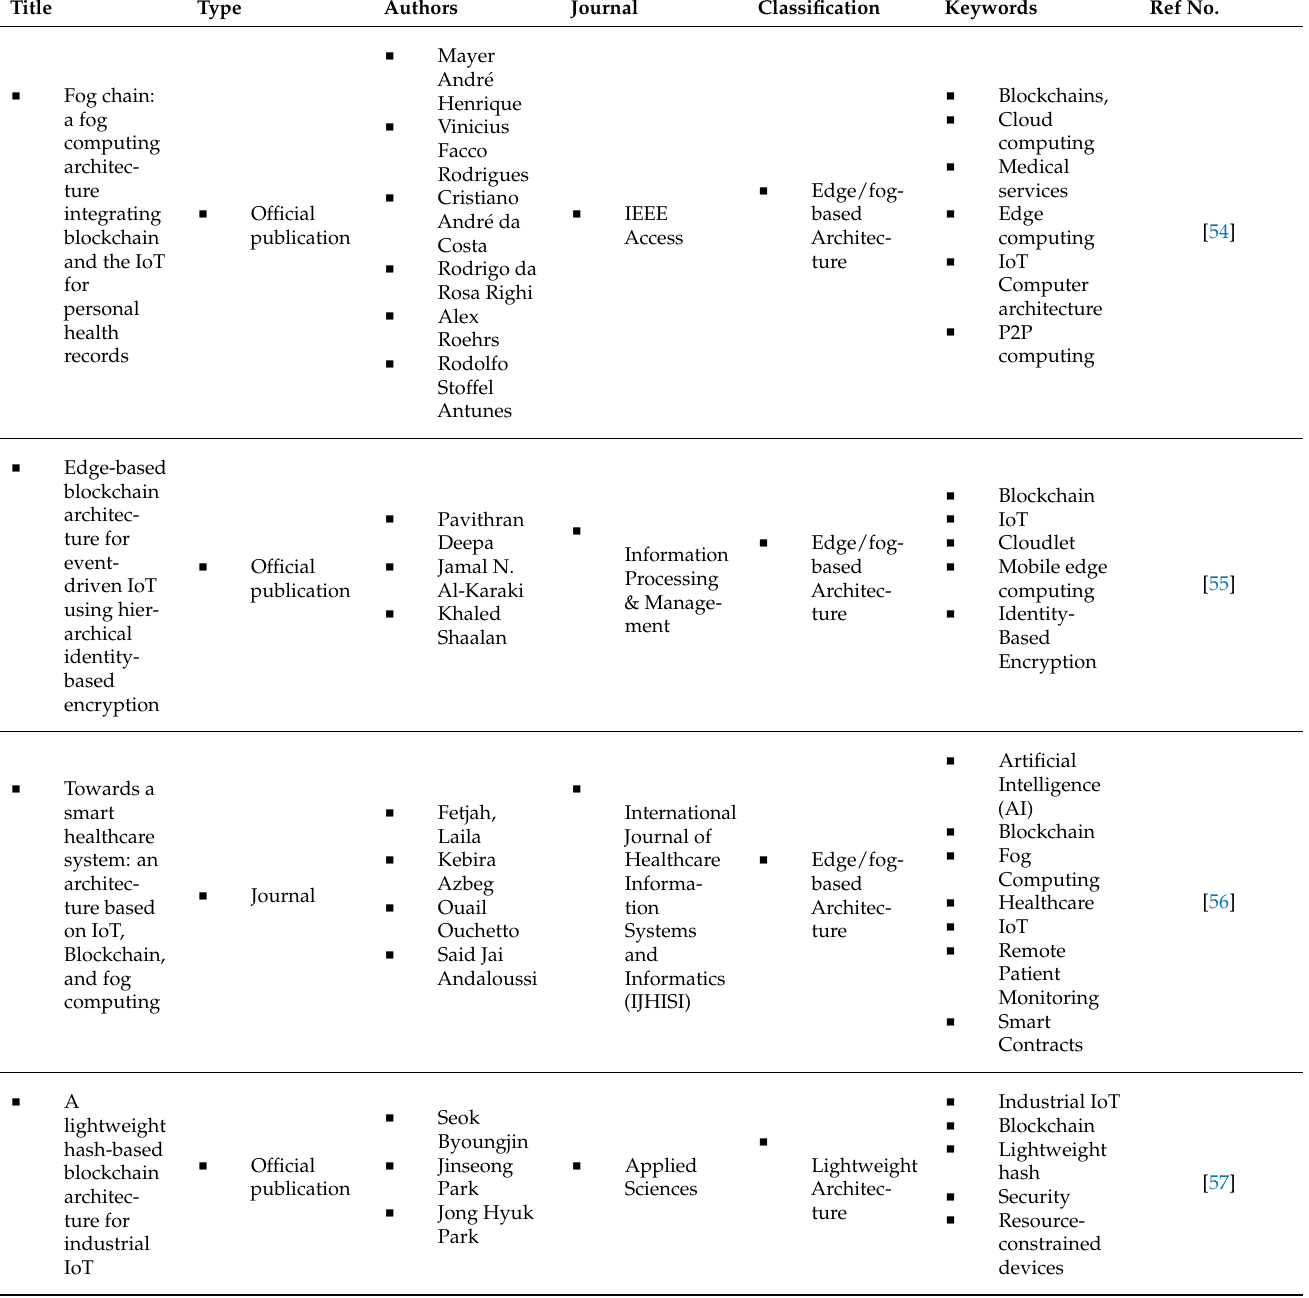
Table 3. Selected Articles.